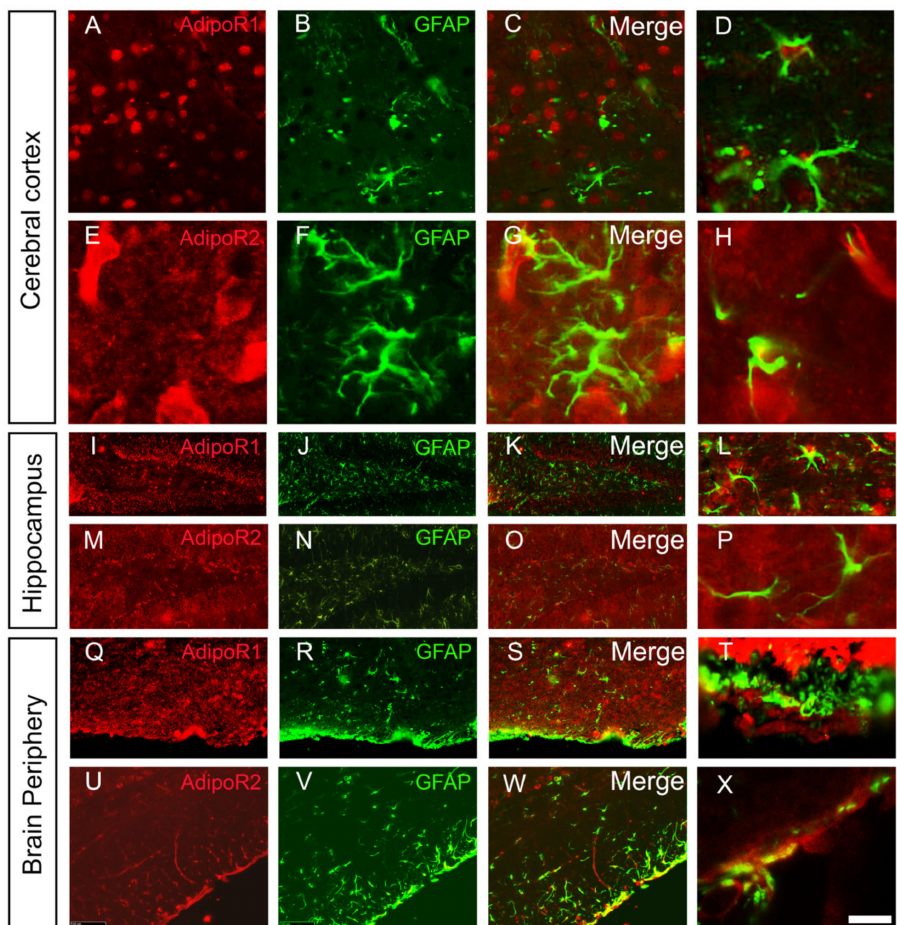
Figure 4. AdipoR1 and AdipoR2 are not strongly expressed by astrocytes but AdipoR2 is detected in some astrocytic end-feet in the ventral part of hypothalamus. ( A ) AdipoR1 and ( E ) AdipoR2 immunostaining (red) with GFAP astrocyte co-labelling (green, ( B , F )) in the cerebral cortex demon- strating no obvious co-staining ( C , D , G , H ). ( I ) AdipoR1 and ( M ) AdipoR2 immunostaining (red) with GFAP astrocyte co-labelling (green, ( J , N )) in the dentate gyrus of the hippocampus demonstrating no obvious co-staining ( K , L , O , P ). ( Q ) AdipoR1 and ( U ) AdipoR2 immunostaining (red) with GFAP astrocyte co-labelling (green, ( R , V )) in the brain periphery demonstrating AdipoR2 staining in some astrocyte end-feet (yellow, ( W , X )) in contrast to AdipoR1 ( S , T ). ( D , H , L , P , T , X ) : Higher magnifications. Scale bar = 7 µ m ( A – H ) and ( L – P ), 100 µ m ( I – W ), 200 µ m ( T – X ).